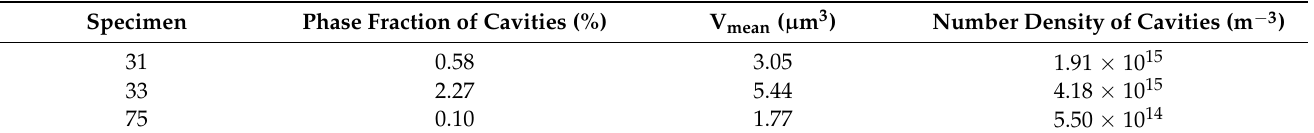
Table 6. Phase fraction, number density of cavities and mean volume per cavity.